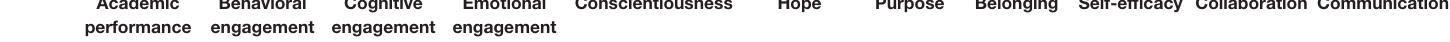
Behavioral Cognitive Emotional Conscientiousness Hope Purpose Belonging Self-efficacy Collaboration performance engagement engagement engagement